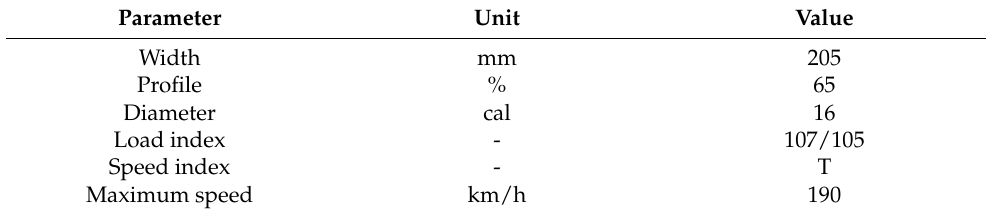
Table 1. Tyre parameters of the Ford Transit test